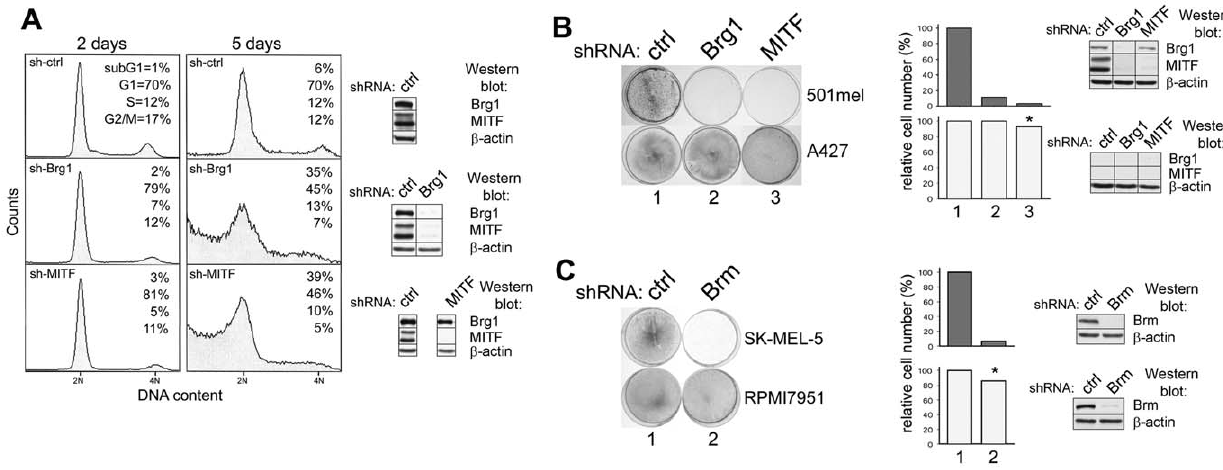
Figure 1. Flow cytometry and colony formation of melanoma cells after knockdown of BRG1, MITF or BRM. A. Effect of BRG1 or MITF depletion on DNA content profile determined by flow cytometry in 501mel cells. Cells were analyzed 2 days after selection in 2.5 m g/ml puromycin (left), or combined (detached and adherent) cells were analyzed 5 days after selection (right). All cells killed by puromycin were removed shortly after antibiotic selection and only puromycin resistant cells were assayed. Right, Western blots verifying the knockdown efficiency for BRG1 and MITF were performed after 2 days followimg the selection. B. BRG1 or MITF depletion inhibits colony formation in 501mel cells. A427 cells (BRG1 and BRM negative) were not affected by sh-BRG1. Middle, the quantitation of cells on dishes shown on the left. Right, Western blots verifying the knockdown efficiency for BRG1 and MITF. C. BRM depletion inhibits cell growth in BRG1-negative SK-MEL-5 melanoma cells, but not control RPMI7951 melanoma cells, which are BRM and BRG1-positive [26] but MITF-negative [33]. Right, Western blots showing the efficient shRNA-mediated BRM downregulation. *, not statistically significant (P , 0.01).